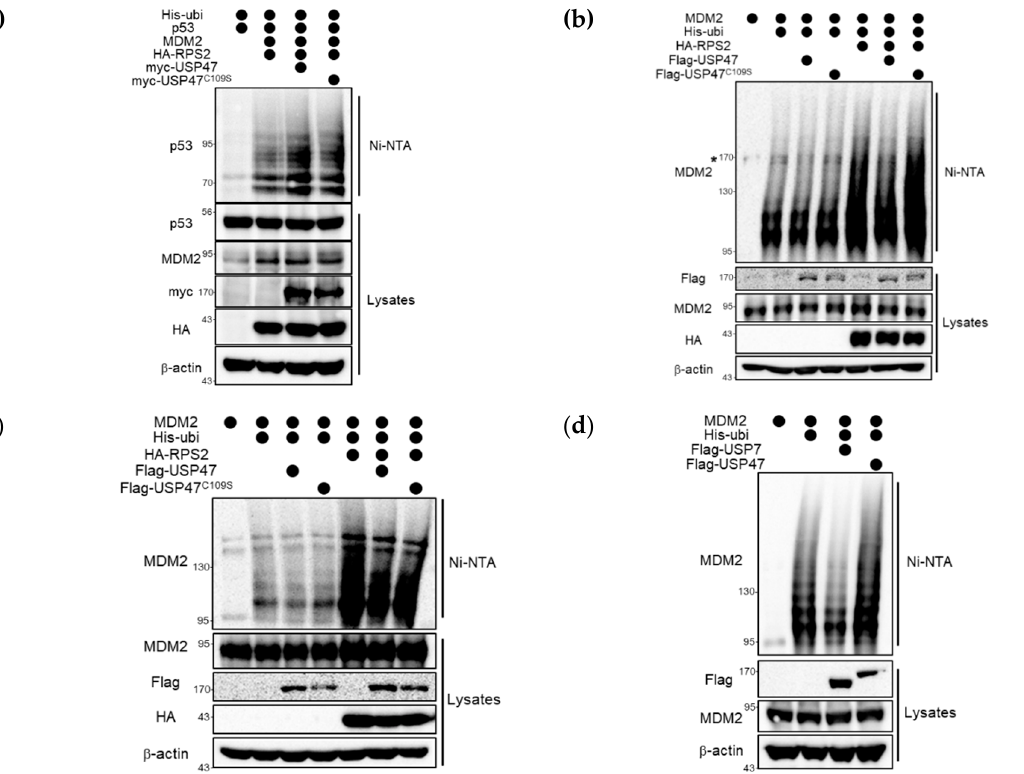
Figure 4. USP47 regulates the ubiquitination of p53 and MDM2. ( a ) HEK293T cells were co-overexpressed with His-ubiquitin, p53, MDM2, HA-RPS2, myc-USP47, or myc-USP47 C109S for 24 h and then treated with MG132 (10 µ M) for 4 h. Ubiquitin conjugates were purified on NiNTA-agarose under denaturing conditions, and ubiquitinated p53 was detected with anti-p53 antibody. ( b ) U2OS cells co-overexpressing His-ubiquitin, HA-RPS2, MDM2, Flag-USP47, or Flag-USP47 C109S as indicated were treated with MG132 (10 µ M) for 4 h. Ubiquitin conjugates were purified on Ni-NTA agarose under denaturing conditions, and ubiquitinated MDM2 was detected with the anti-MDM2 antibody. The non-specific band is denoted by an asterisk. ( c ) H1299 cells were co-overexpressed with MDM2, His-ubiquitin, HA-RPS2, Flag-USP47, or Flag-USP47 C109S and then treated with 10 µ M MG132 for 4 h. Ubiquitin conjugates were purified on Ni-NTA agarose under denaturing conditions, and ubiquitinated MDM2 was detected by anti-MDM2 antibodies. ( d ) HEK293T cells were overexpressed with MDM2, His-ubiquitin, and Flag-USP7 or Flag-USP47 and then treated with 10 µ M MG132 for 4 h. Ubiquitin conjugates were purified on Ni-NTA agarose under denaturing conditions, and ubiquitinated MDM2 was detected by anti-MDM2 antibodies. The uncropped blots and molecular weight markers are shown in Figure S7.